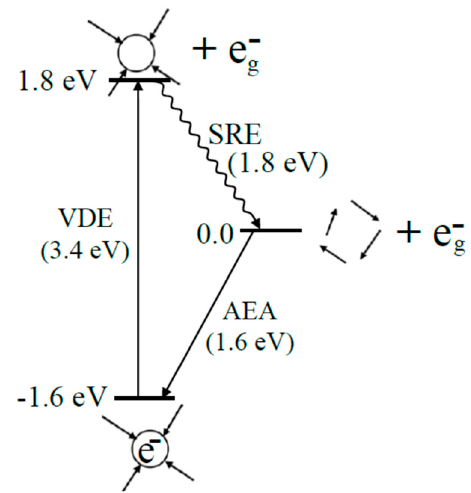
Figure 2. Schematic diagram showing the energy cycle for the adiabatic electron affinity (AEA), the photo-ejection of the solvated electron (e − aq ) into the gas phase (VDE), and the solvent reorganization to equilibrated water (SRE = 1.8 eV). For the VDE, the water molecules have the same geometry for the upper state as in the ground state. The difference between AEA and VDE gives the value of SRE (solvent reorganization energy). The wavy line indicates the solvent reorganization. The SRE shows the solvent after photo-ejection of the electron is unstable by ca. 1.8 eV over a stable water phase geometry, see references [25,31]. Reprinted with permission from reference [72]. Copyright, 2016, American Chemical Society.